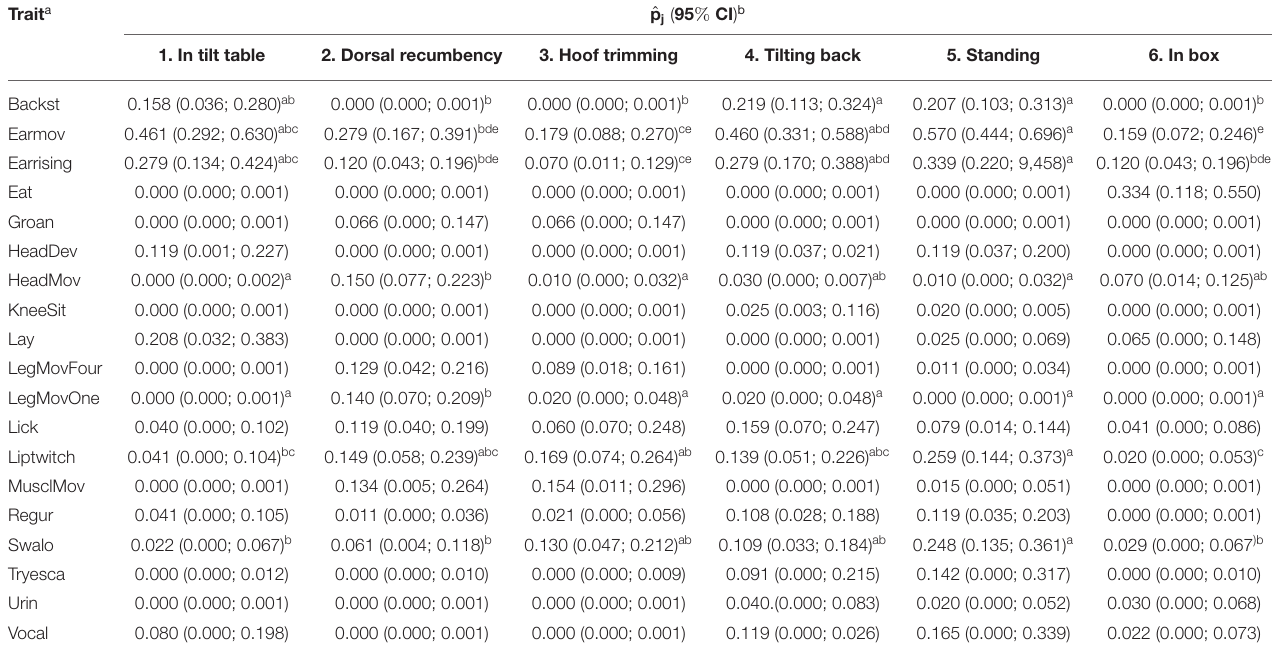
TABLE 6 | Estimated probabilities (Tukey-test). Trait